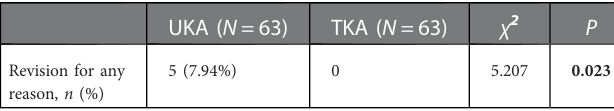
TABLE 6 Comparison of knee prosthesis revision between two